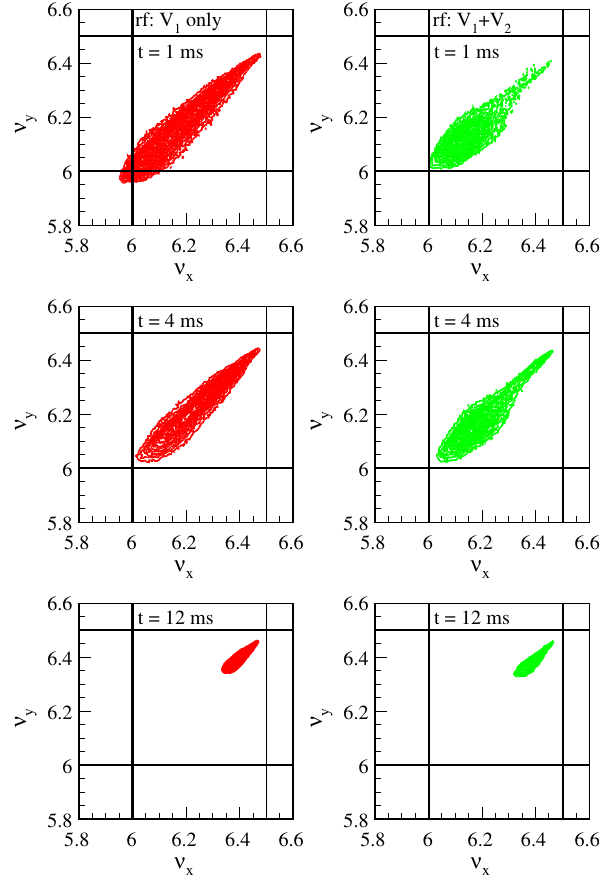
FIG. 8. Betatron tune footprints at the end of injection obtained in the simulation by using single (left) and dual (right) rf voltages for a beam power of 0.375 MW. The solid black lines are the integer and half integer resonances at ν x;y ¼ 6 and ν x;y ¼ 6 . 5 ,